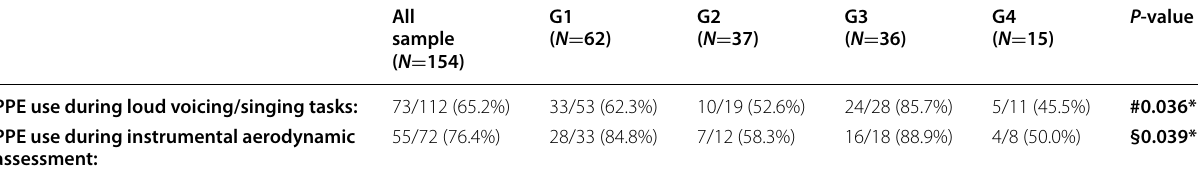
Table 5 Participants’ adherence to personal protective equipment (PPE) use during examinations and procedures